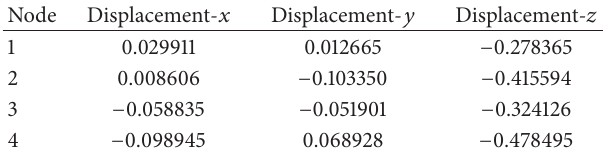
Table 2: The displacements (in m) at nodes 1, 2, 3, and 4 using the nonlinear FEM for the first experiment. The displacements of nodes 5 to 8 for all axes are zero.